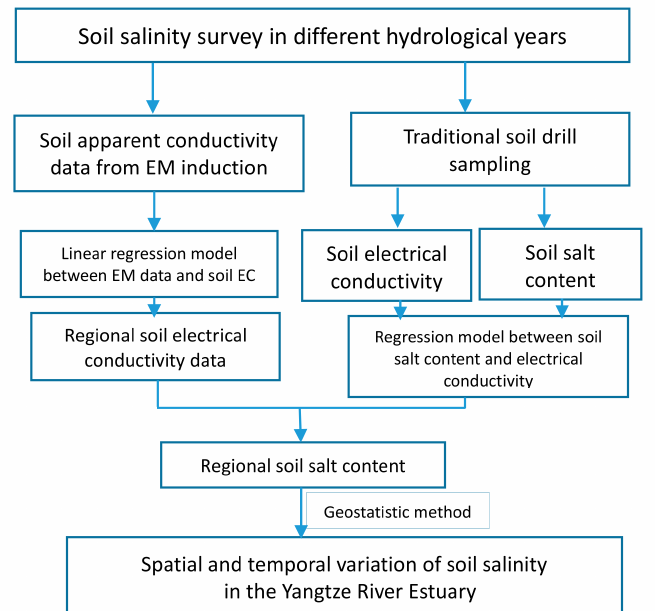
Figure 1. Flowchart of the